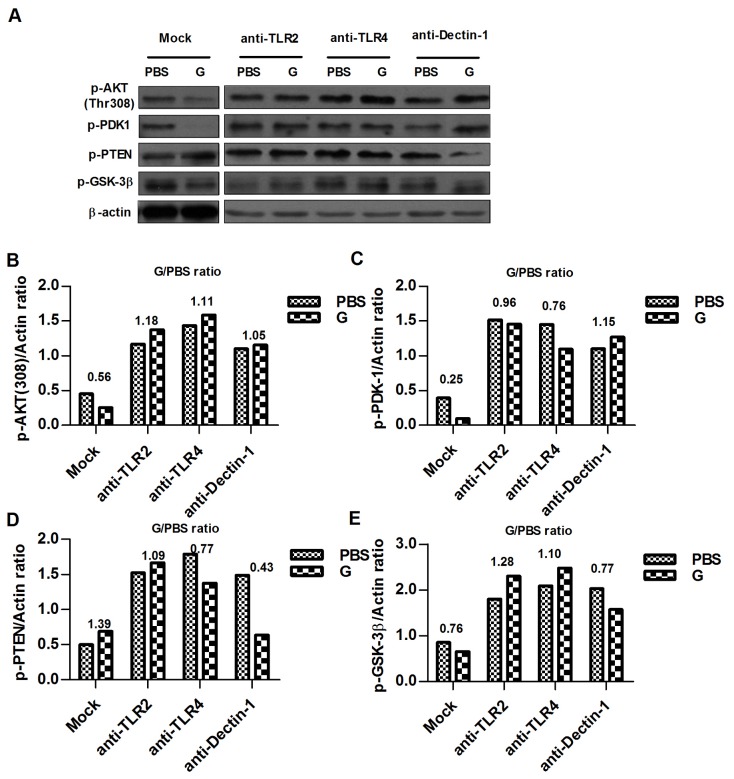
β-glu6 (G) modulates the PI3K/Akt signaling pathway.Macrophages were incubated with β-glu6 (100 μg/mL) alone for 2 h or pre-treated with anti-TLR2, anti-TLR4 or anti-Dectin-1 antibodies for 1 h. The Akt (Thr308), PTEN, PDK-1, and GSK-3β phosphorylation were detected by western blot assay, and beta-actin was used as a loading control (A). The band intensities were analyzed by Quantity One software (B, C, D and E). The numbers above the bars stand for the G/PBS ratio. Data shown represent one of three independent experiments.